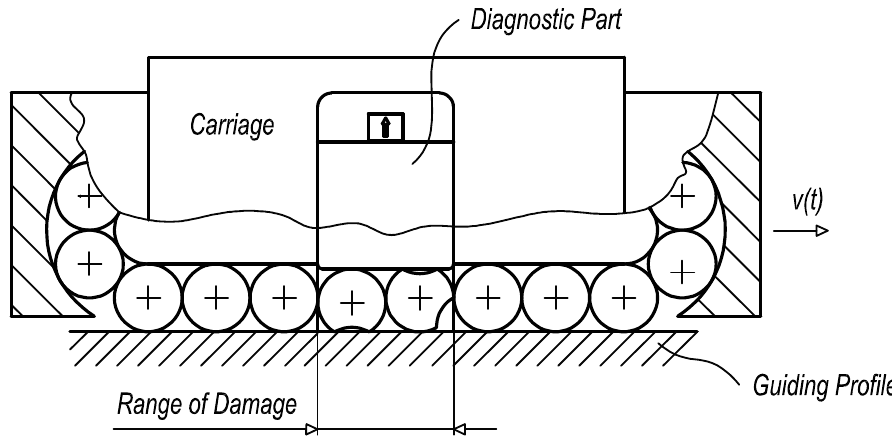
Figure 9. The limit range of rolling elements damage.